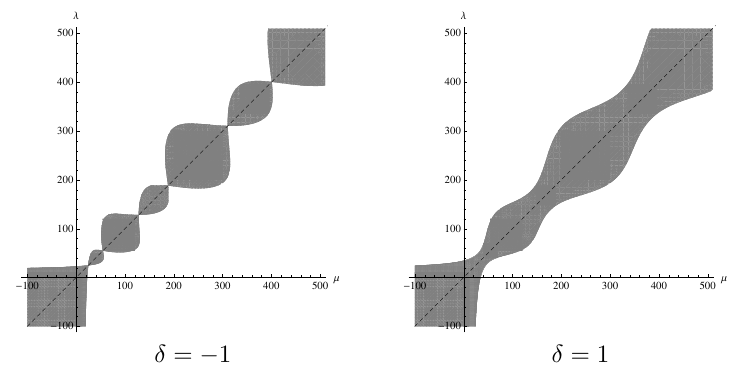
Figure 9. Solvability regions for the the problem (1.7),